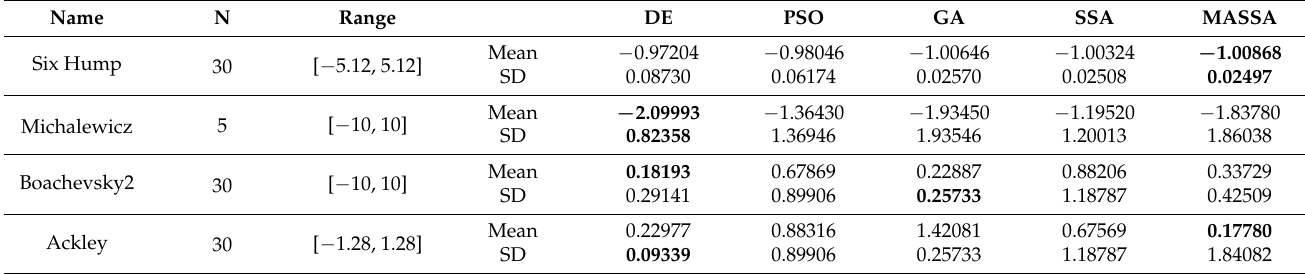
Table 6. Result of multimodal benchmark